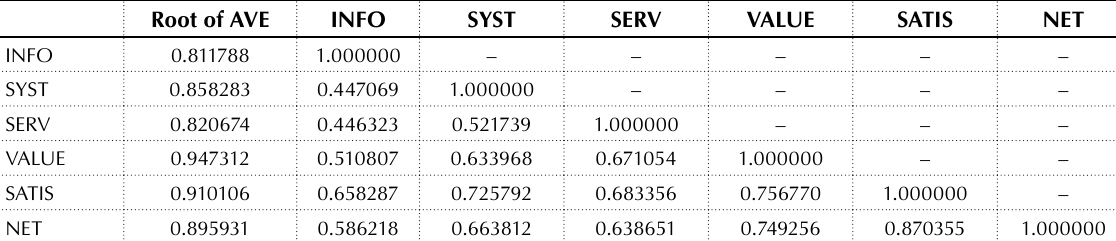
Table 3. Root of AVE and latent variable